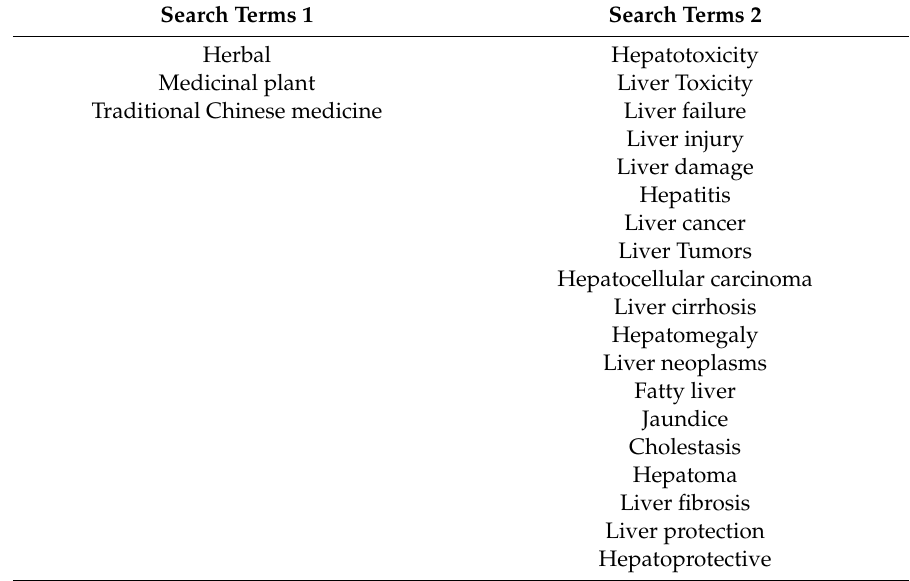
Table 4. Search terms for compounds with potential hepatotoxicity or